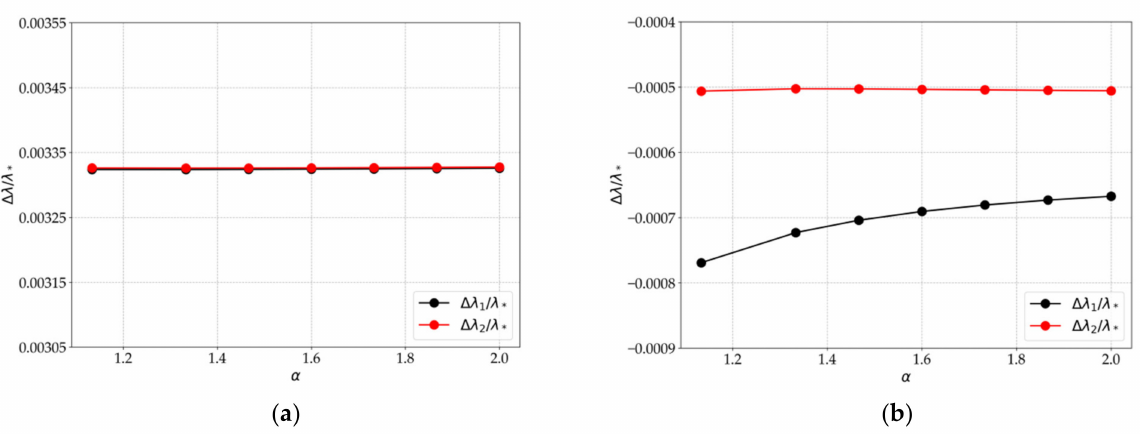
Figure 6. The values of ∆ λ 1 / λ ∗ and ∆ λ 2 / λ ∗ at different values of α and loads F 1 = P 0 , F 2 = 0 ( a ); F 1 = 0, F 2 = P 0 ( b